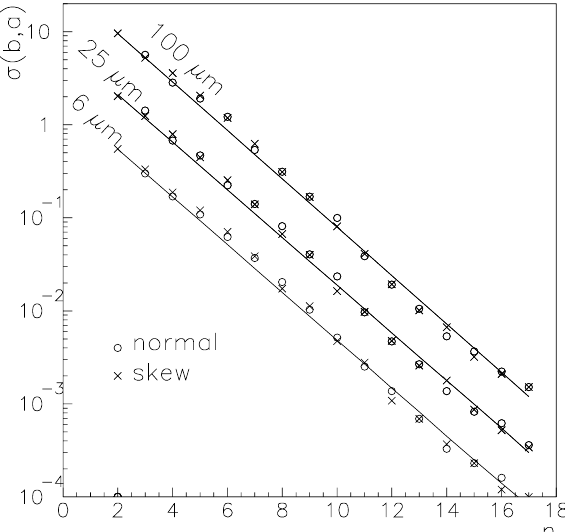
FIG. 7. Numerical estimate (markers) and parabolic fit (solid line) of the geometric random multipoles due to random block displacements of different amplitudes d for the four-block coil of the main LHC quadrupole.